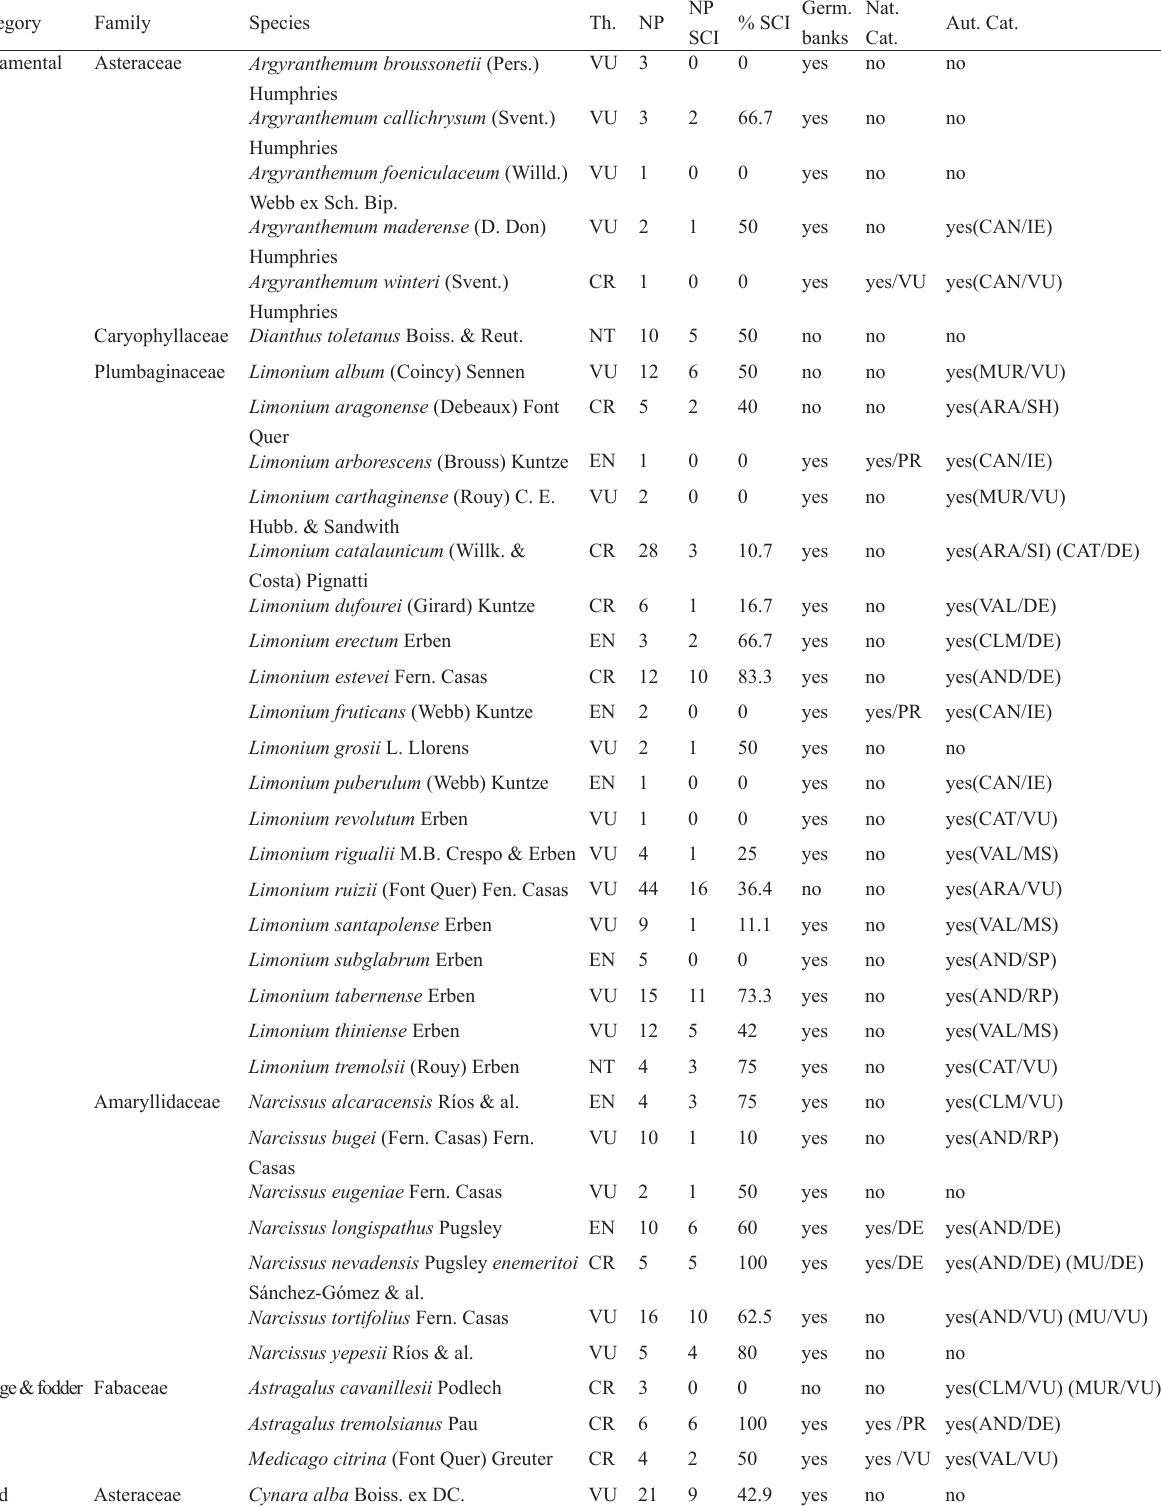
Table 2. List of species associated to category, family and threat category according to IUCN standards (Th.), number of populations (NP), number of populations inside the network of Sites of Community Importance of Natura 2000 (NP SCI) and percentage in relation to total number of populations (%SCI), presence of accessions preserved in national and international germplasm banks (Germ. banks), inclusion of the species in the National Catalogue of Threatened Species (Nat. Cat.; R.D. 139/2011) and inclusion of the species in the catalogues of the autonomous